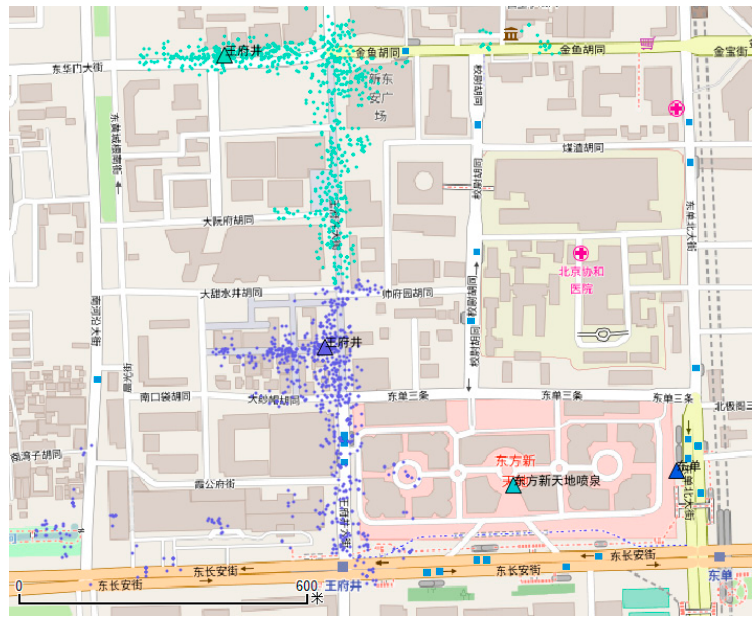
Figure 8. Preliminary clustering outputs for the Wangfujing area.